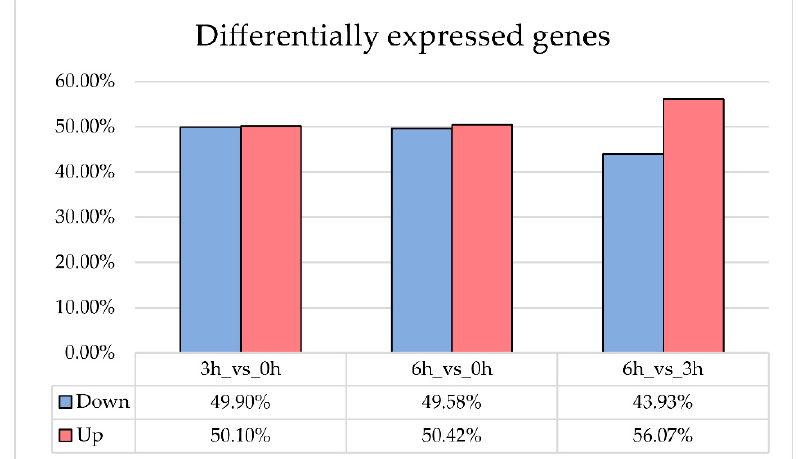
Figure 2. Differentially Expressed Genes (DEGs) in A2E-treated RPE cells. The histogram shows DEGs detected in RPE cells treated with A2E when compared to untreated cultures. Values are expressed in percentage. For each time point considered, blue bars indicate the down-expressed genes, while red ones refer to up-regulated genes. Both A2E-treated cells and control H-RPE cells were exposed to a blue light period.